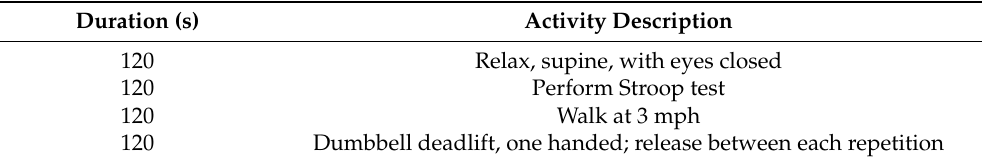
Table 1. Experimental